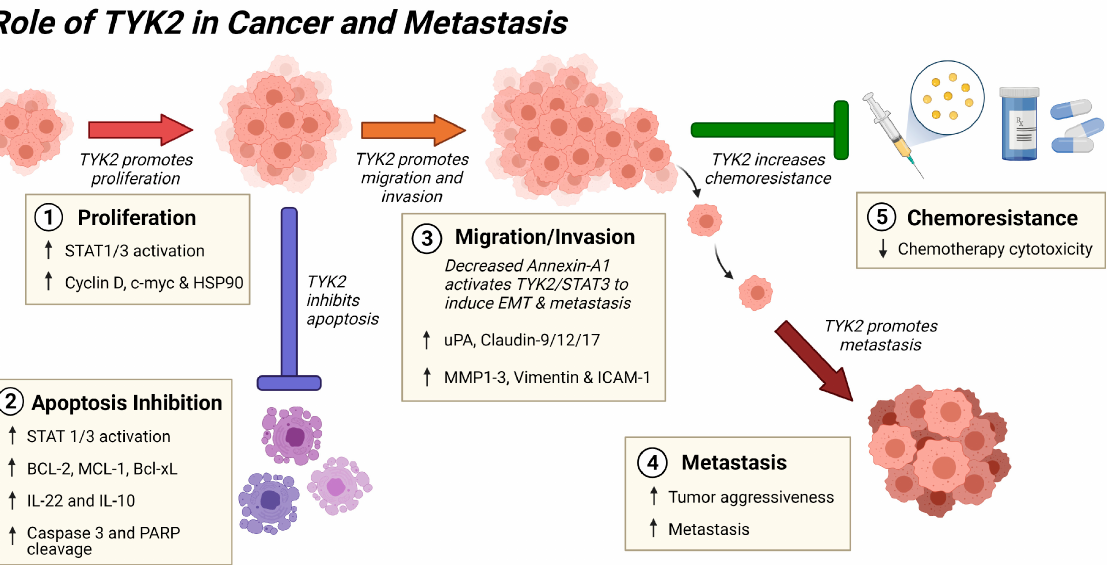
Figure 3. Summary of the role of TYK2 signaling in cancer progression and metastasis. TYK2 activates STATs to inhibit cancer cell apoptosis [18,20,41,106,108,109] while stimulating proliferation [20,41,106,108,113], migration, invasion [113–118], and resistance to chemotherapy [107]. These functions of TYK2 lead to increased tumor aggressiveness and metastasis [14,20,22,36,106], resulting in greater patient mortality. Arrows ( ↑ or ↓ ) indicate direction of gene expression or protein activation change. Illustration created with BioRender.com.